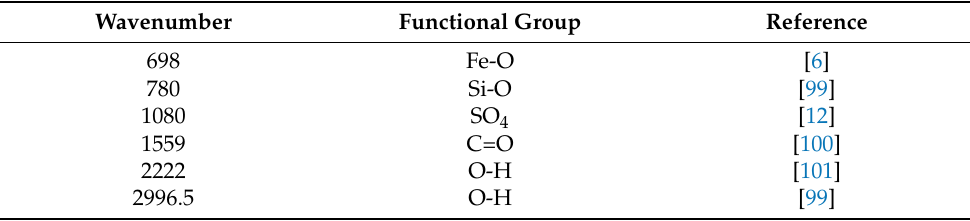
Table 5. The metals’ functional groups and their